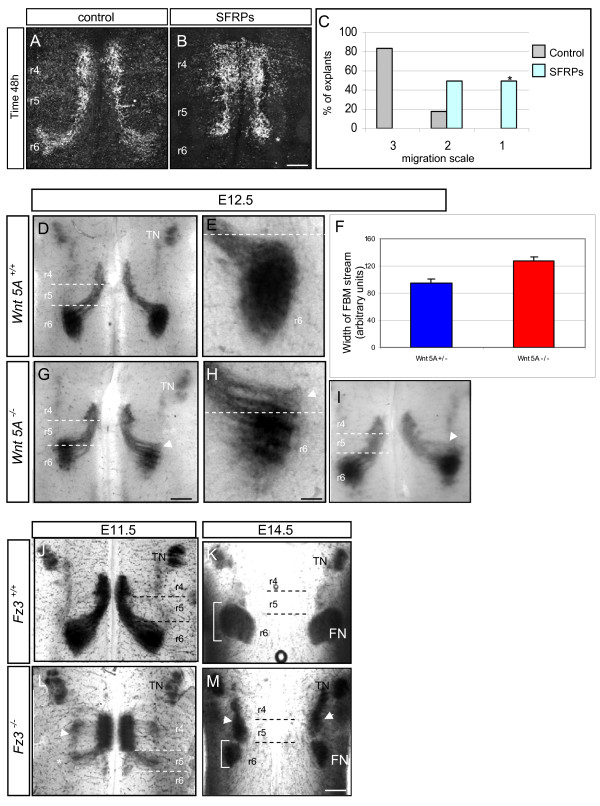
Analysis of the effects of attenuation of Wnt signalling on facial branchiomotor (FBM) migration. (A, B) Control hindbrain explant (A) and secreted frizzed-related protein (SFRP)-treated explant (B) immunostained for Islet-1/2 after 48 hours in vitro. (C) Quantification of FBM migration in hindbrain explants treated with SFRPs. SFRP-treated versus control p < 0.01 (indicated by asterisk), n = 10 explants in each group. (D, E, G-M) Analysis of mutant phenotypes by in situ hybridisation with Islet-1 probe. (D, E, G-I) Flat-mounted hindbrains of embryonic stage (E)12.5 mouse embryos of Wnt5A+/+ (wild type) and homozygote mutant litter-mates Wnt5A-/- in which a stream of cells (arrowheads in (G-I)) is located in rhombomere (r)5 and does not reach their final position in r6 compared to wild type (D). (E, H) Higher magnifications of FBM neurons in wild type and homozygote mutant showing a decompacted nucleus in the latter. (F) Quantification of the migration defect by measurement of the width of the FBM migratory stream showing this is increased in Wnt5A mutants. N = 8; p < 0.05 (error bars = sems). (J, L) Flat-mounted hindbrains of E11.5 mouse embryos of Fz3+/+ (wild type) and its Fz3-/- litter-mate homozygote mutant in which a striking loss of migration of the FBM population can be observed. In the Fz3-/- mutant a much reduced stream of cells migrated caudally into r5 (asterisk) and there is aberrant dorsolateral migration of FBM neurons in r4 (arrowhead). (K, M) At E14.5, FBM neurons in homozygote Fz3-/- hindbrains (M) contain an FBM nucleus in r6 that is much smaller than in the wild-type (K) and there are ectopic dorsal nuclei in r4 and r5 (arrowheads). Brackets in (K, M) indicate the smaller size of the FBM nucleus in Fz3-/- mutant. Scale bars: in (B), 250 μm and applies to (A, B); in (G), 375 μm and applies to (D, G, I,); in (H), 125 μm and applies to (E, H); in (M), 375 μm and applies to (J, M). FN, facial nucleus; TN, trigeminal nucleus.